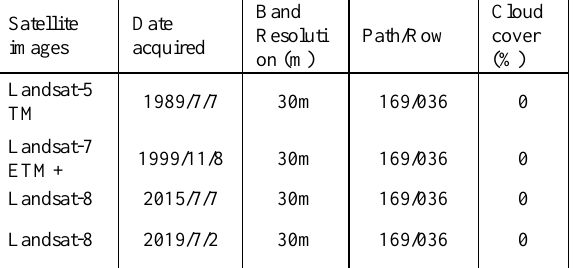
Table 1. Landsat image categories used in the study. Upon further observation of all SI values, the classifications for most of the segments show ranges indicating rivers being sinuous and meandering.